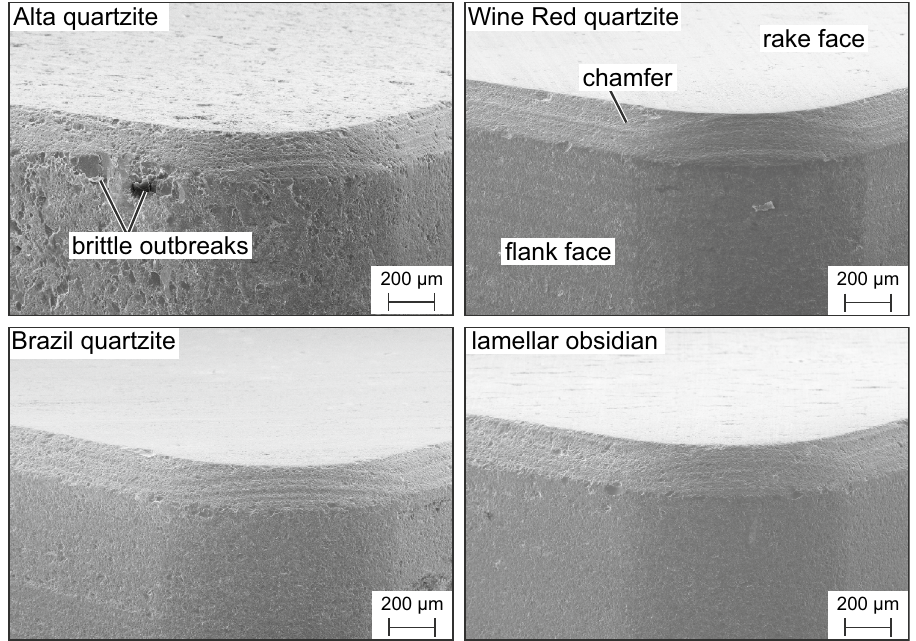
Fig. 10 SEM-images of the surface of the indexable inserts made from rock by a plunge face grinding